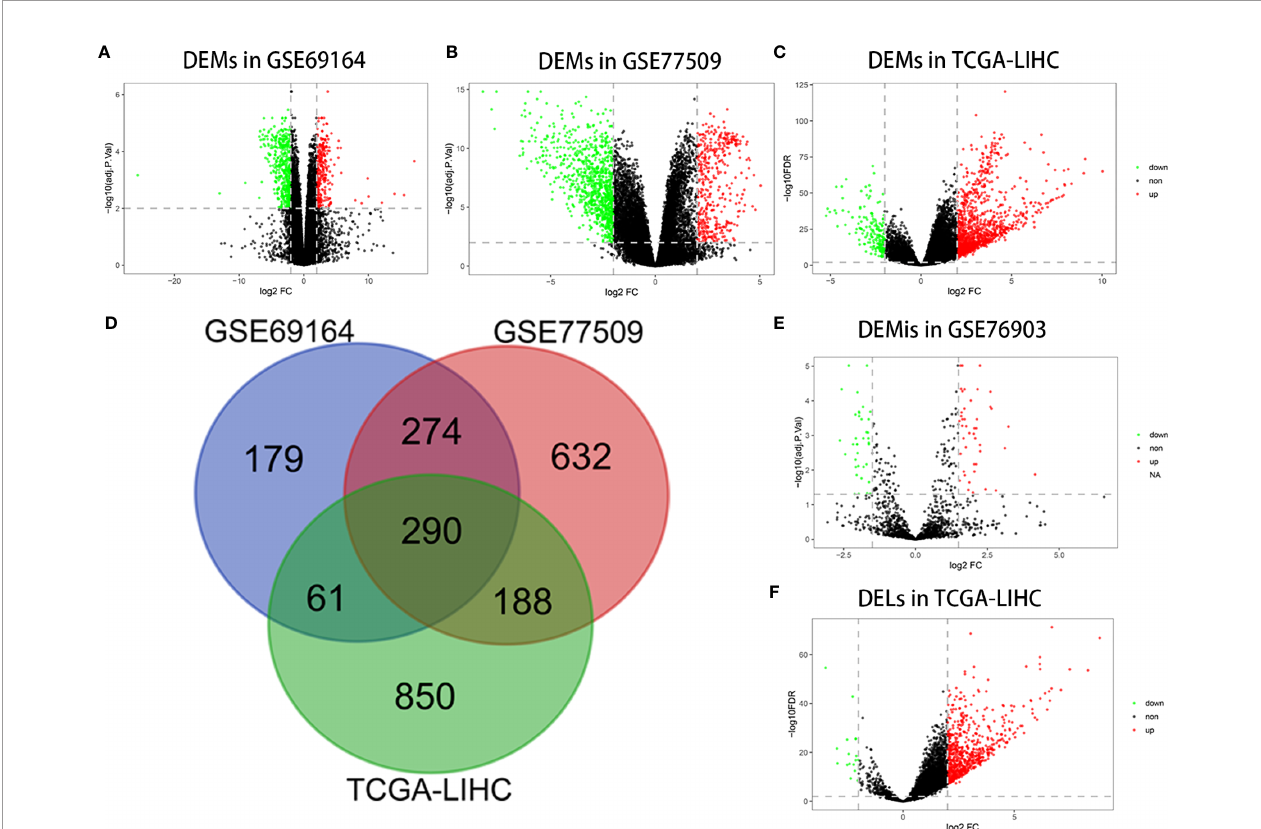
FIGURE 1 | Differentially expressed RNAs analysis. (A) DEMs in GSE69164 identi fi ed using the limma package. (B) DEMs in GSE77509 identi fi ed using the limma package. (C) DEMs in TCGA-LIHC identi fi ed using the DESeq2 package. (D) Overlapping DEMs. (E) DEMis in GSE76903 identi fi ed using the limma package. (F) DELs in TCGA-LIHC identi fi ed using the DESeq2